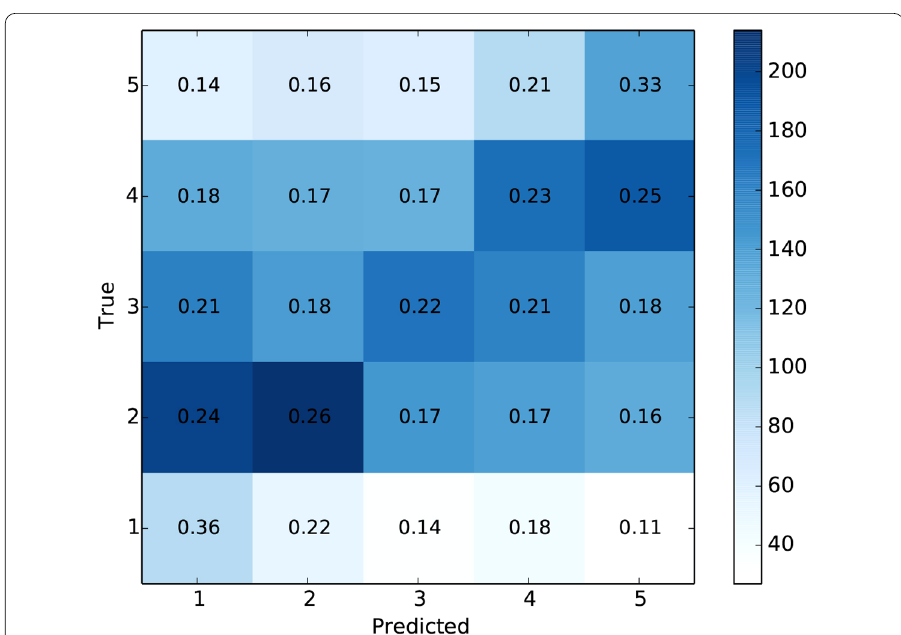
Figure 8 Income prediction confusion matrix with colors encoding the number of data points in each income bin. The numbers within each cell represent the absolute size normalized by the total size of the true income bin. Note that since income categories are sorted from very poor (1) to very rich (5), the deviation of our income predictions from truth is small for most income